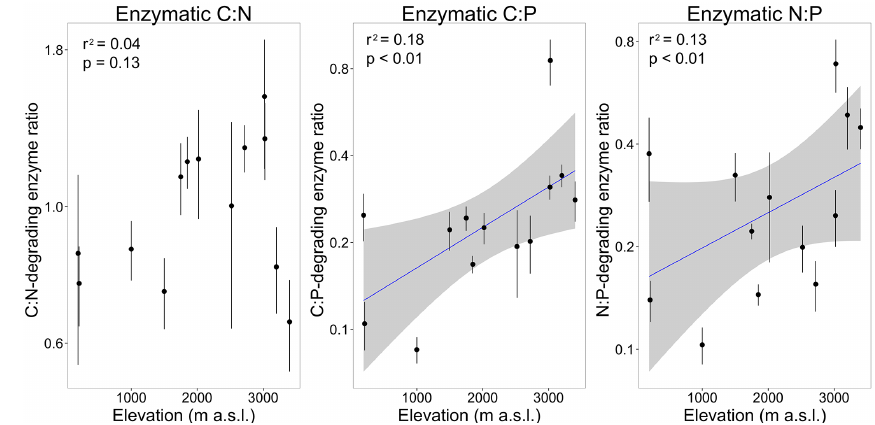
Figure 5. The stoichiometry of C ( β -glucosidase), N ( N -acetyl β -glucosaminidase) and P (phosphomonoesterase) – degrading enzyme activity along a tropical forest 3400m elevation gradient. Enzymes activities were determined at the mean annual temperature for each site. Linear models (including all 13 sites) explained the variation in enzymatic ratios with elevation for C:P en ( R 2 = 0.18, p <0.001) and N:P en ( R 2 = 0.13, p <0.01), but not C:N en ( R 2 = 0.04, p = 0.13). Values are means ± 1 SE ( n =